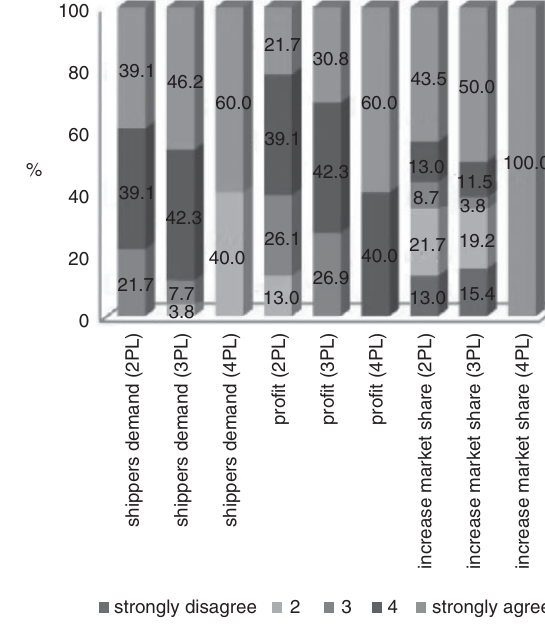
Fig. 1. Reasons for offering outsourcing